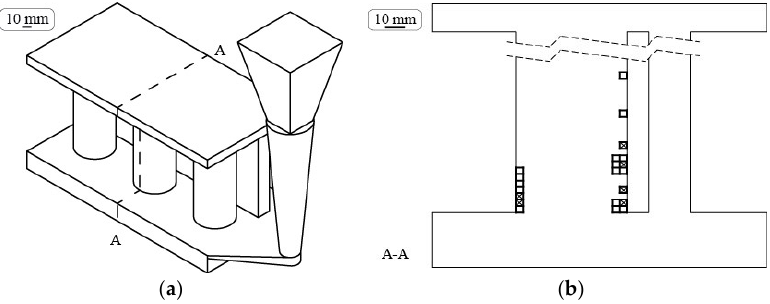
Figure 1. ( a ) Isometric view of the shrinkage porosity (SP) sample; ( b ) Cross ‐ section view of the SP sample.